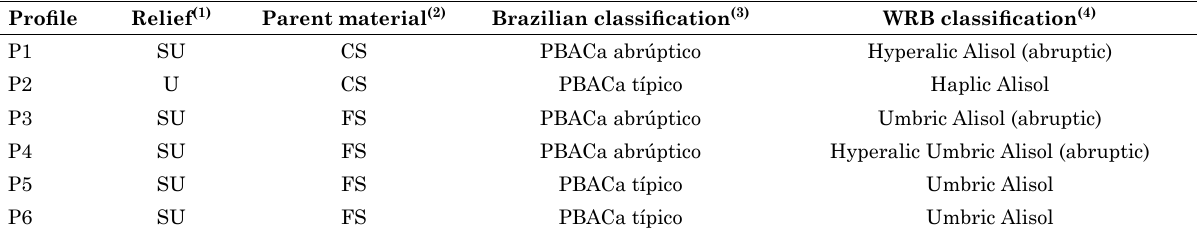
Table 1. Environmental characterization and taxonomic classification of the soil profiles